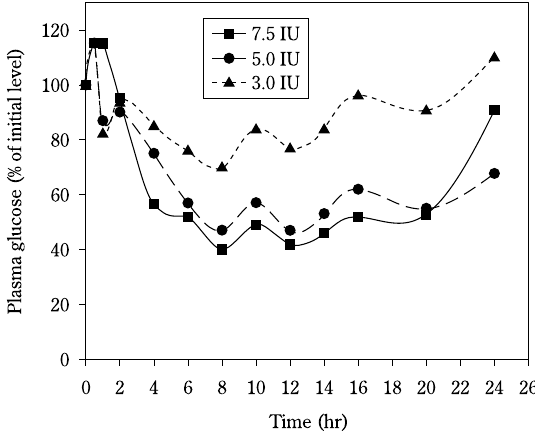
Fig. 10 Nanoparticles effect on blood glucose level change of mouse at abstention state in vivo